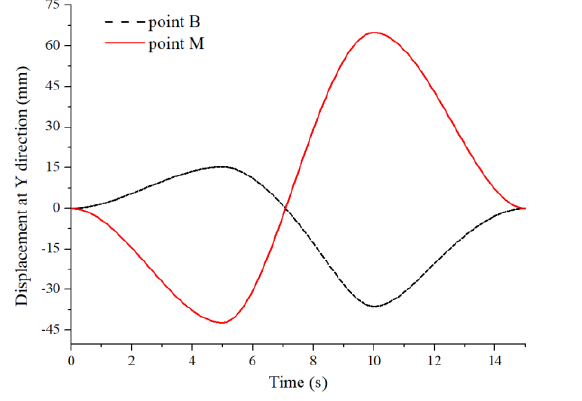
( b ) Figure 11. Simulation results of lateral tilting adjustment: ( a ) Left-leaning simulation diagram of chassis. ( b ) Hydraulic cylinder displacement and lateral inclination θ 1 . Based on the above analysis, the lateral tilt leveling can be achieved by controlling the front hydraulic cylinder on one side alone, the overall lifting can be achieved by ad- justing the front hydraulic cylinder on both sides at the same time, and the longitudinal tilting leveling can be realized by adjusting the rear hydraulic cylinders. Only the same